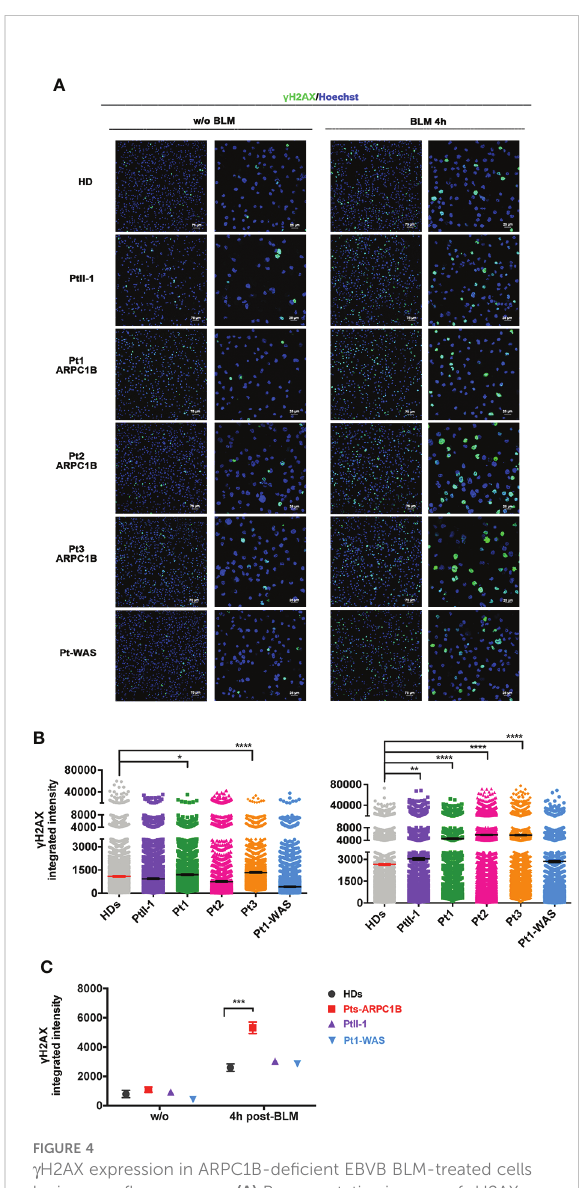
FIGURE 4 g H2AX expression in ARPC1B-de fi cient EBVB BLM-treated cells by immuno fl uorescence. (A) Representative images of g H2AX (green) and nuclei counterstaining (blue) investigated on cells from PtII-1, Pt1-3 ARPC1B, Pt1-WAS, and HD before and after 4 h of BLM treatment (9 µM/1 h). Each left column shows ×20 magni fi cation, and each right column shows ×60 magni fi cation. Bar scale represented 75 µm (×20) and 25 µm (×60). (B) Histograms show the g H2AX-integrated intensity evaluated in the patient ’ s EBVB cells compared to HDs ( n = 4; HDs = 4). Each point represents the integrated intensity of a single cell. The line indicates the mean ± SEM ( n > 2). (C) The graph shows a between-group statistical comparison of the g H2AX-integrated intensity detected in PtII-1, ARPC1B-, and WAS-disease group of patients against the HD group. The statistical analyses were performed with two-way ANOVA and Bonferroni ’ s posttest: * p < 0.05, ** p < 0.01, *** p < 0.001, and **** p <